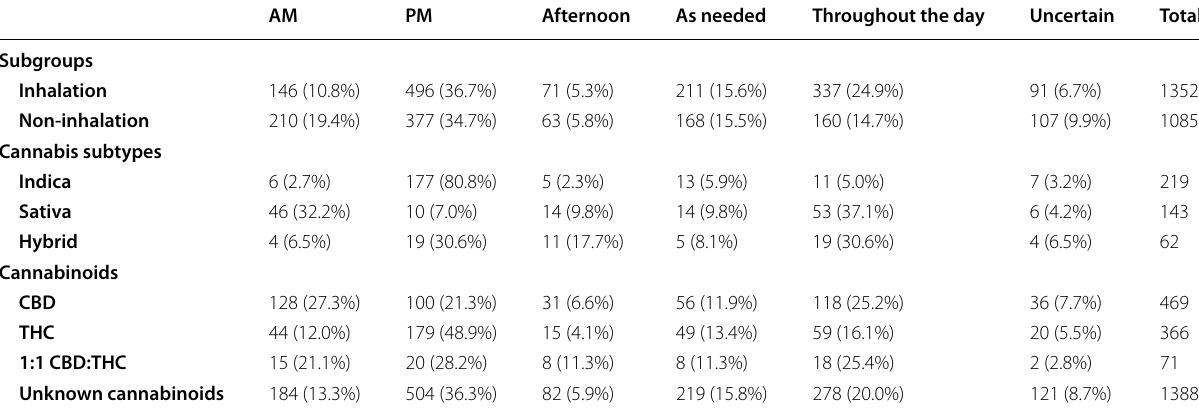
Table 3 Timing of use with regards to administration route categories, cannabis sub-types, and cannabinoids